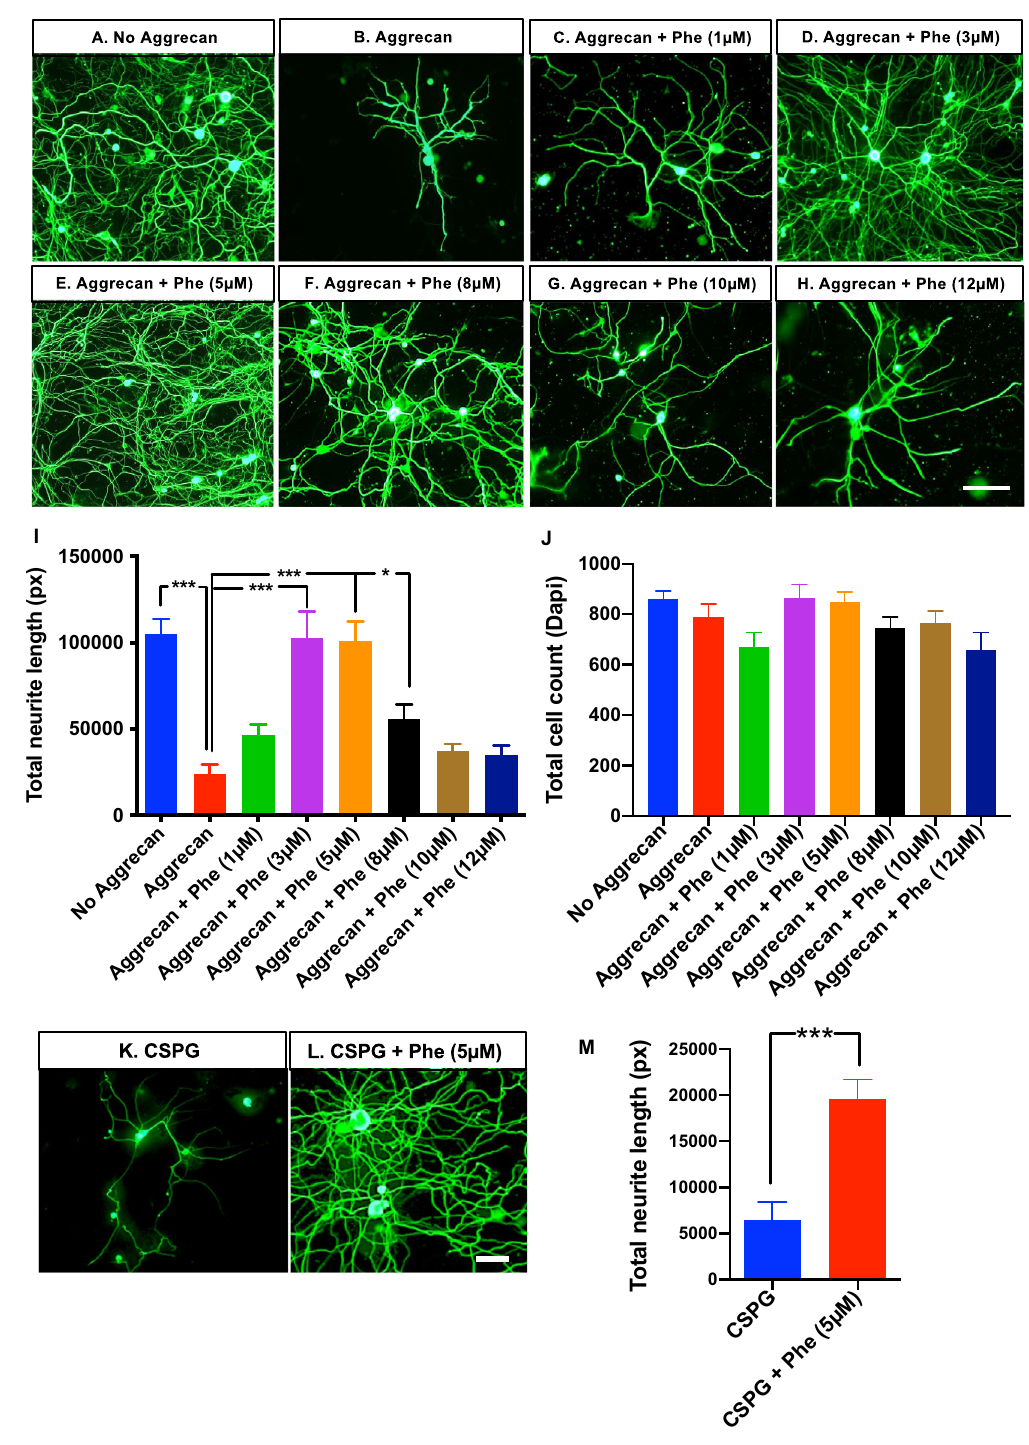
Figure 1. Effect of phentolamine on DRG neuron outgrowth in vitro. ( A – H ) Representative images of DRG neurons from 4–6 week old C57BL/6 J mice, cultured for 72 h on the mixture of poly-d-lysine PDL and laminin (Lam) substrates, ( A ) without aggrecan ( B ) with aggrecan ( C – H ) aggrecan with phentolamine (Phe) at concentrations, ( C ) 1 µM, ( D ) 3 µM, ( E ) 5 µM, ( F ) 8 µM, ( G ) 10 µM, and ( H ) 12 µM. Cultured neurons were immunostained with an anti-neuronal marker, β-tubulin III, to identify the neurite